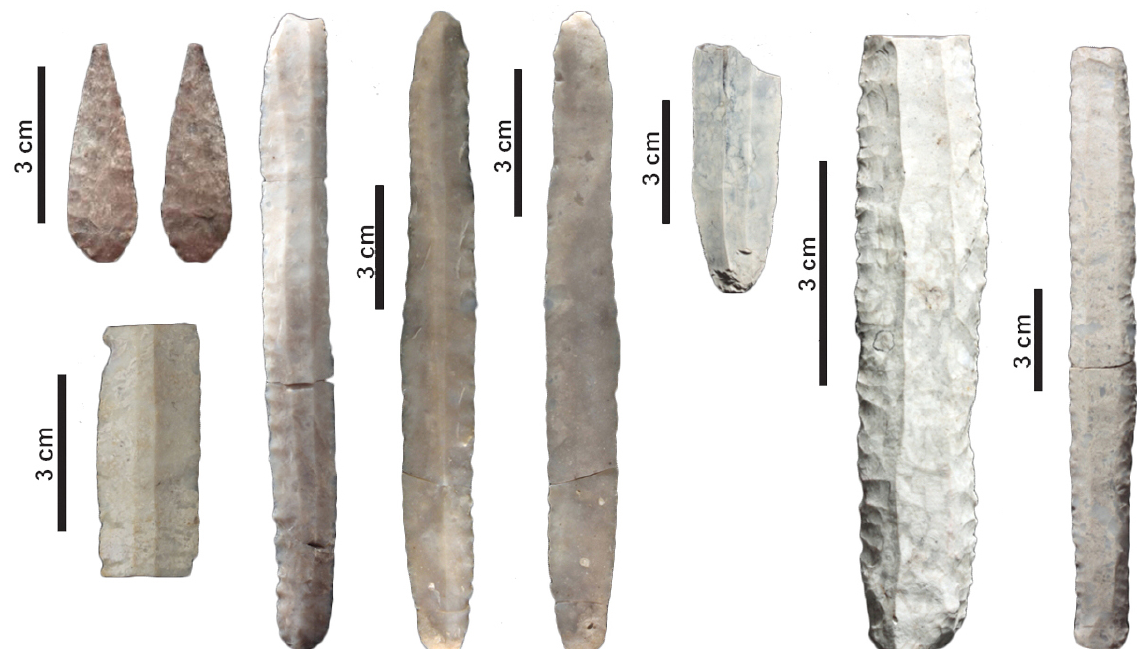
Figure 5. The lithics analysed from Cova del Pantà de Foix